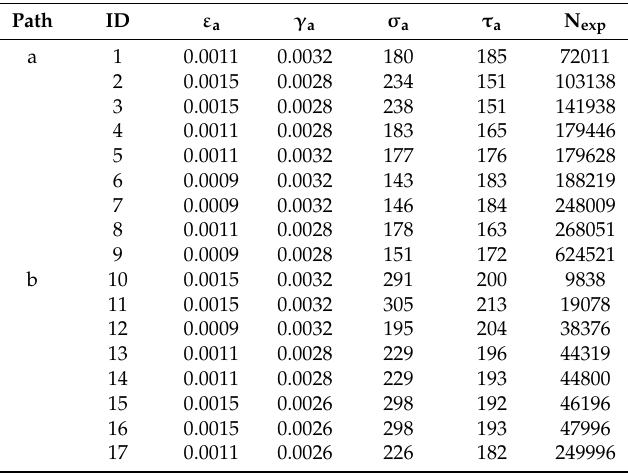
Table 6. S355-J2G3 Fatigue experimental